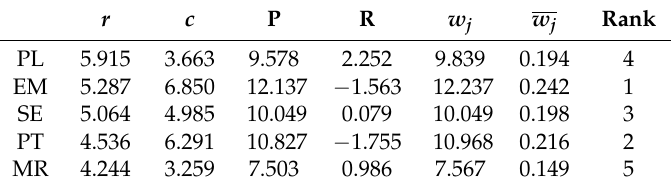
Table 7. Influences among the criteria and their relative weights of risk